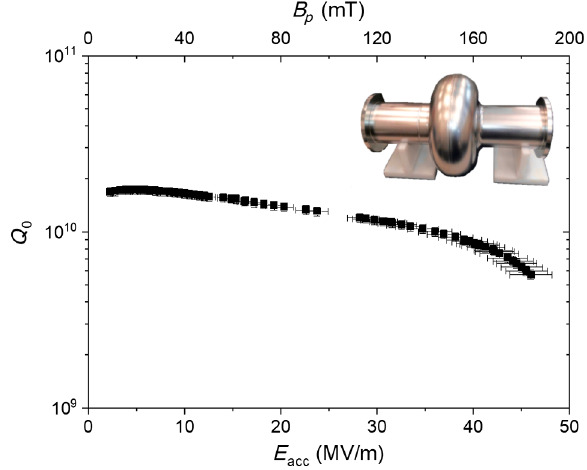
FIG. 6. Results from the rf test in superfluid He at 2.0 K of the 952.6 MHz prototype single-cell Nb cavity. A picture of the cavity is shown in the inset.